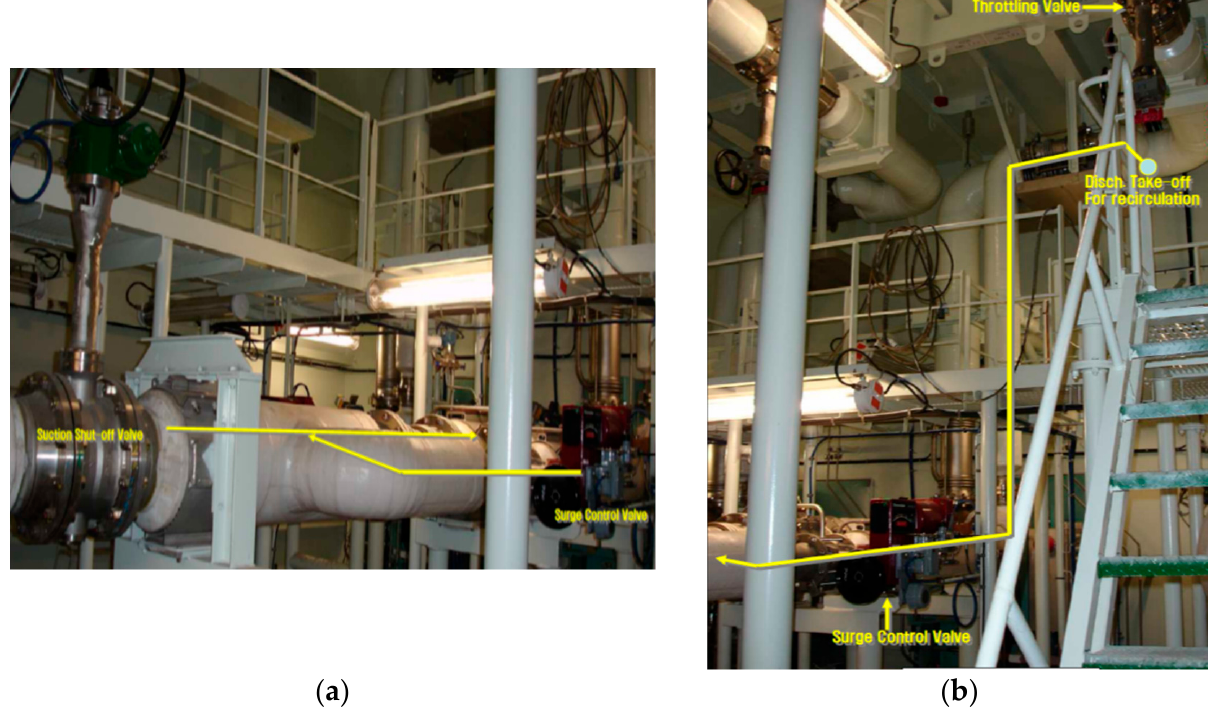
Figure 4. Photographs of ( a ) the compressor suction and ( b ) the throttling valve. To describe the unsteady part of the compressor performance curve, the cubic polyno- mial of Moore and Greitzer [16] was used. Figure 6a shows the fitted curves based on the measured steady-state performance for the three speeds. In Figure 6b, the unsteady part was approximated using the cubic polynomial from Moore and Greitzer